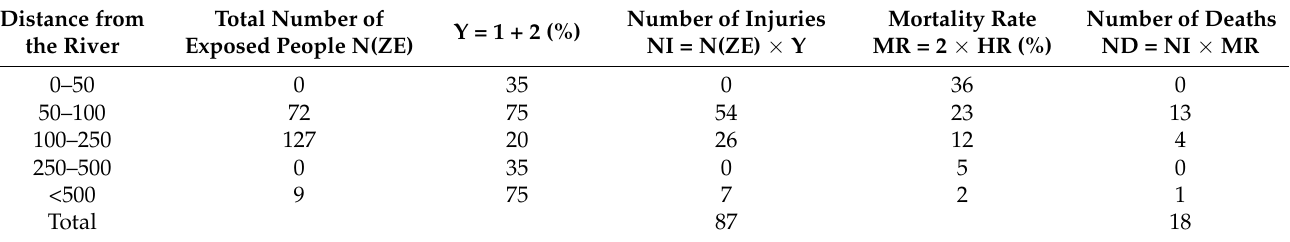
Table 7. Total number of injuries and